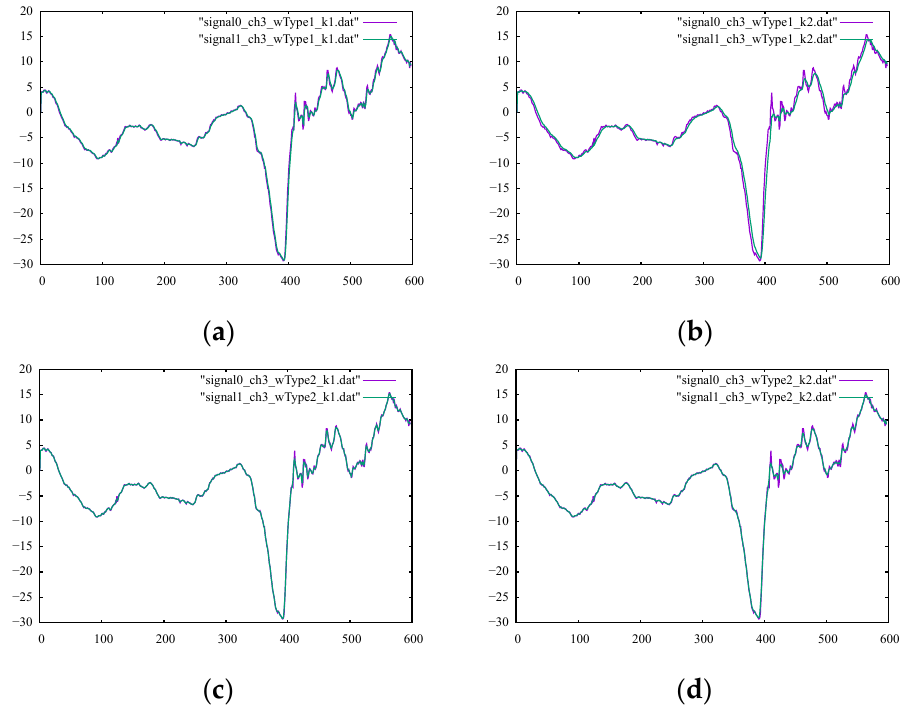
Figure 6. Original noisy motion signal from channel 3 of the root-joint of the kicking character versus the smoothed signal via the moving average filter using ( a ) an asymmetric window of size 2, ( b ) an asymmetric window of size 3, ( c ) a symmetric window of size 3, and ( d ) a symmetric window of size 5.